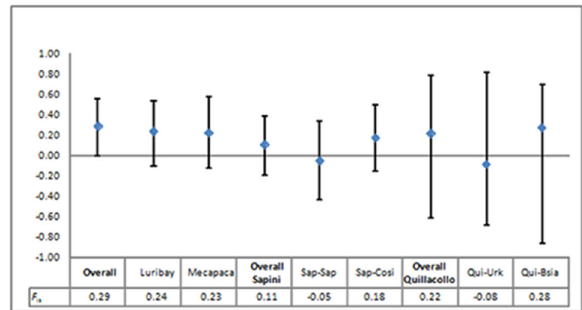
Figure 2. Observed F of the six Trypanosoma cruzi is populations under study and three artificial clusters (all stocks from Sapini, all stocks from Quillacollo, and all TcI Bolivian stocks) and their 95% confidence intervals.